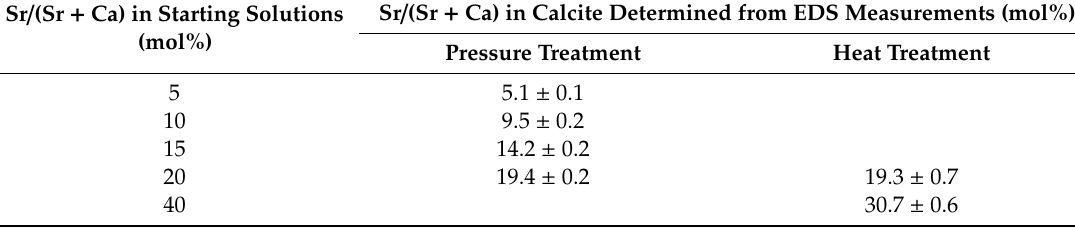
Table 2. Sr / (Sr + Ca) of calcite samples determined from Energy-dispersive X-ray spectroscopy (EDS) measurements. The calcite samples listed in this table contained no strontianite (SrCO 3 ). Sr / (Sr + Ca) in Starting